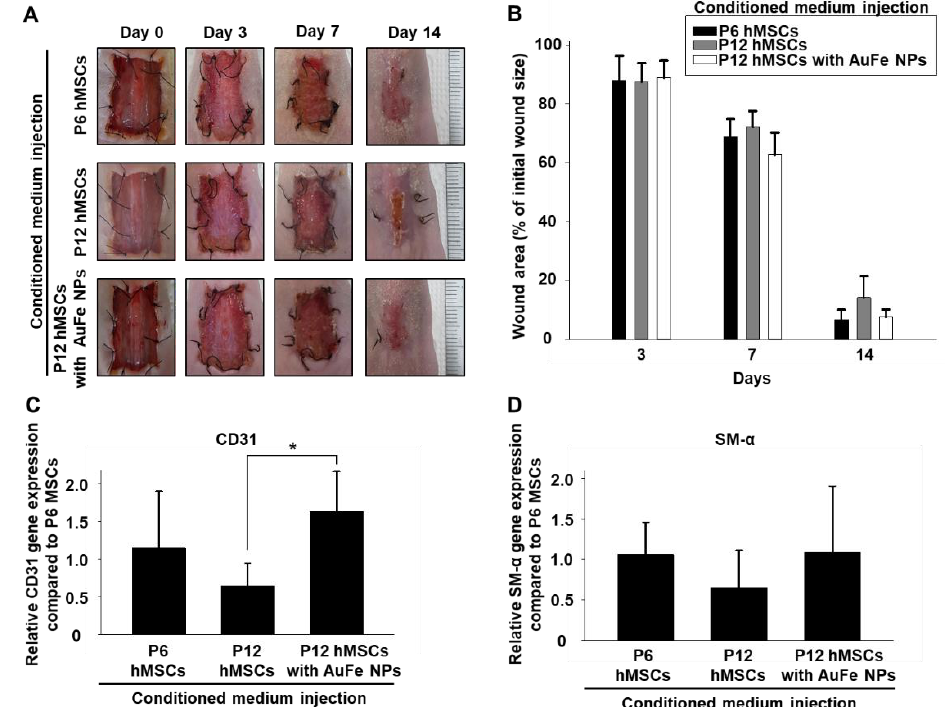
Figure 4. ( A ) Representative images of full-thickness skin wounds at various time points after injecting CM collected from the untreated P6 (P6 NT group) and P12 hMSCs (P12 NT group), as well as AuFe NP-treated P12 hMSCs (P12 AuFe group). ( B ) Wound closure rates ( n = 4). Relative gene expression of ( C ) CD31 and ( D ) SM α -actin in wound regions ( n = 4, * p < 0.05) at 14 days after treatment.